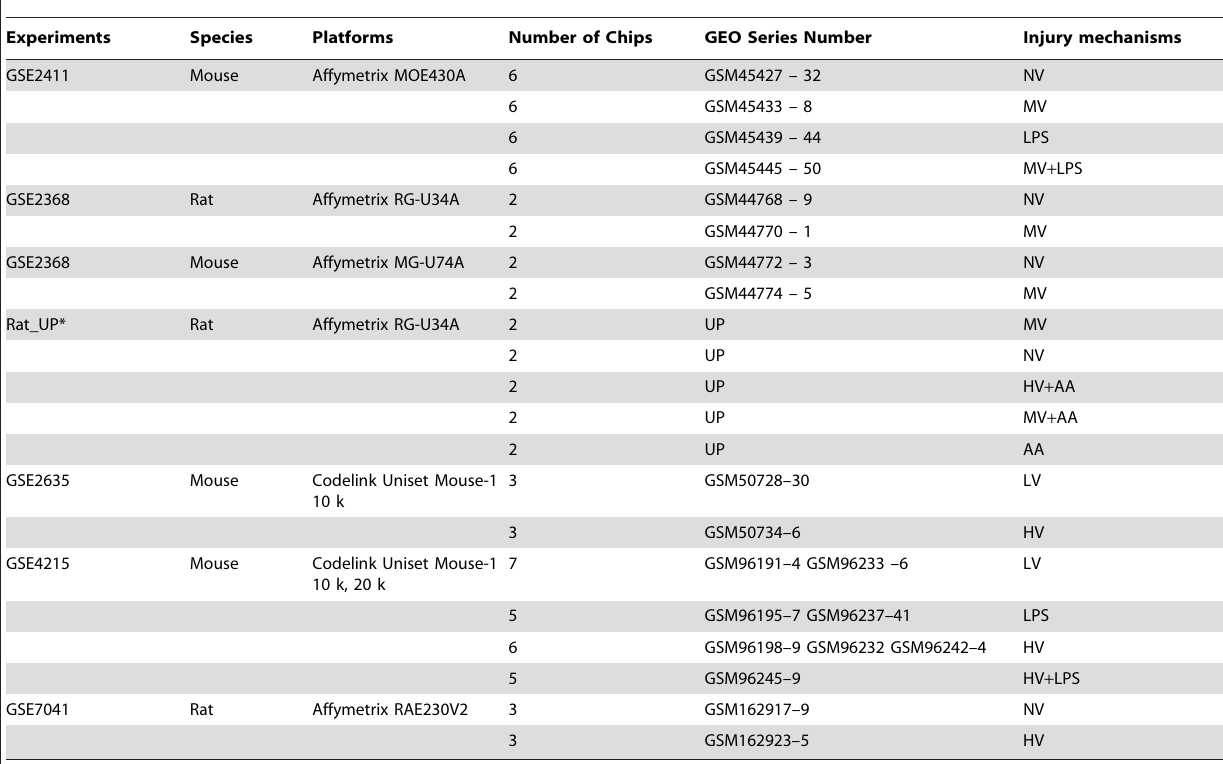
Table 1. Summary of experiments included in microarray meta-analysis.